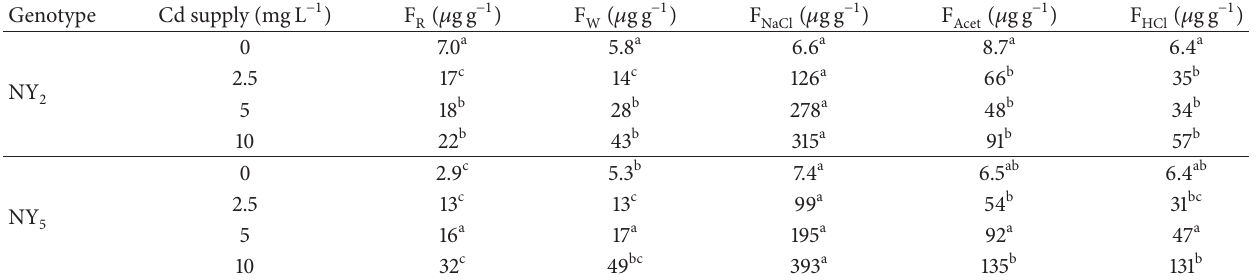
Table 4: Cd chemical forms of stems in two Jerusalem artichoke